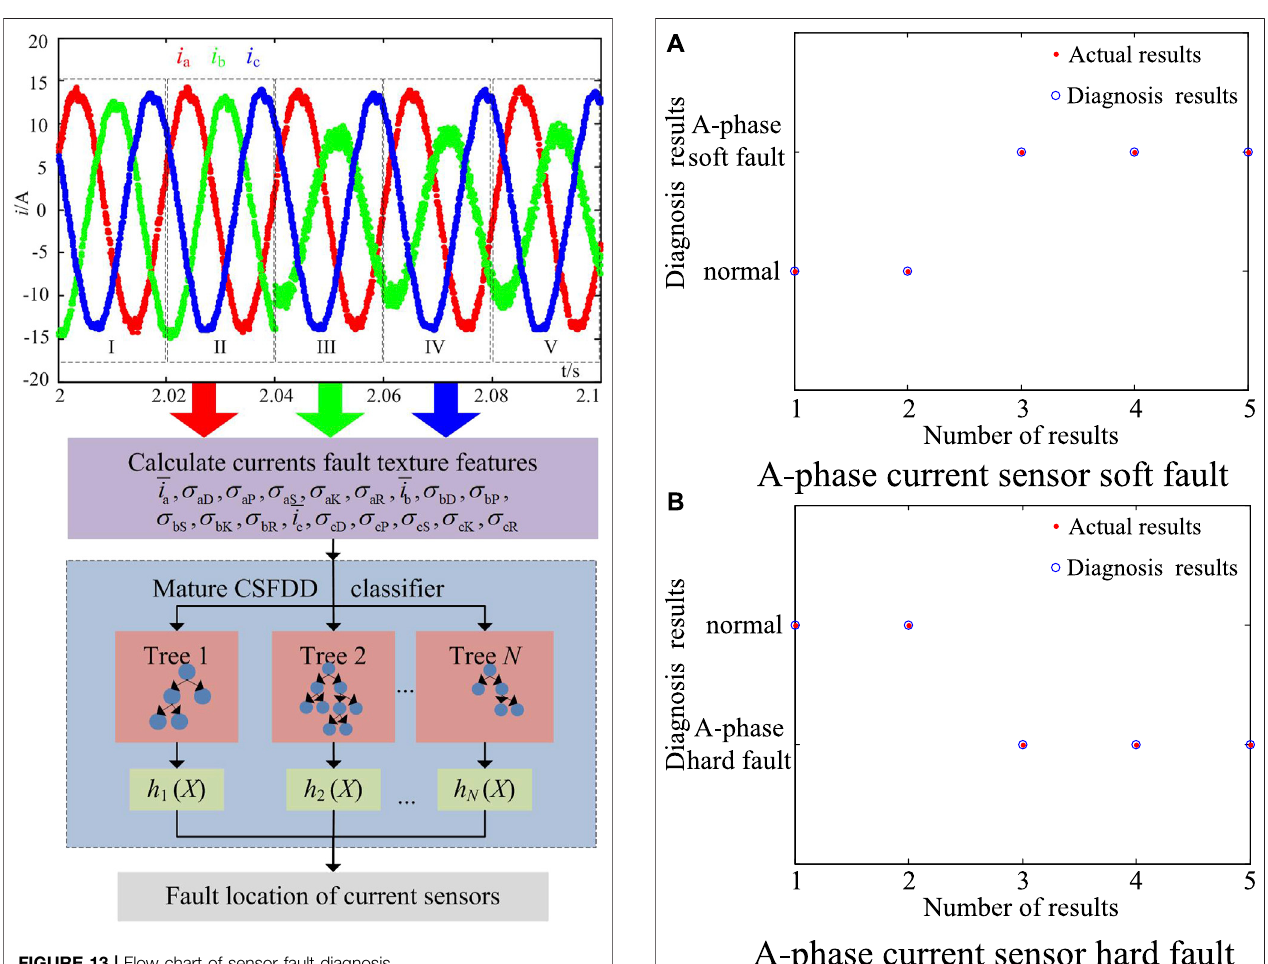
FIGURE 13 | Flow chart of sensor fault diagnosis.